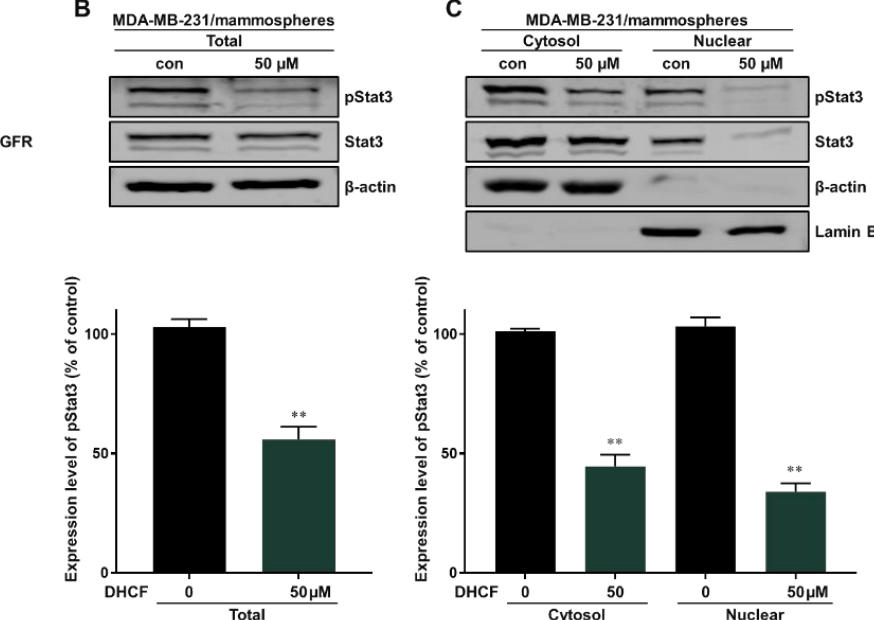
Figure 6. Dihydroconiferyl ferulate inhibits the interaction between EGFR and Stat3. ( A ) Stat3 and EGFR were immunoprecipitated with anti-Stat3 antibody from mammosphere extracts after treat- ment with dihydroconiferyl ferulate (50 µM) for 48 h. Immunoblotting was carried out using the anti-EGFR antibody. ( B ) Results of immunoblot analysis showing the levels of pStat3 and Stat3 in total proteins measured in mammosphere extracts after treatment with dihydroconiferyl ferulate (50 µM) for 48 h. ( C ) The nuclear levels of pStat3 and Stat3 proteins were determined in mam- mospheres derived from MDA-MB-231 treated with dihydroconiferyl ferulate (50 µM) or DMSO for 48 h. Dihydroconiferyl ferulate decreased the levels of p-Stat3 and Stat3 in mammospheres. Data from experiments represent the mean ± standard deviation; ** p < 0.01 vs. control.